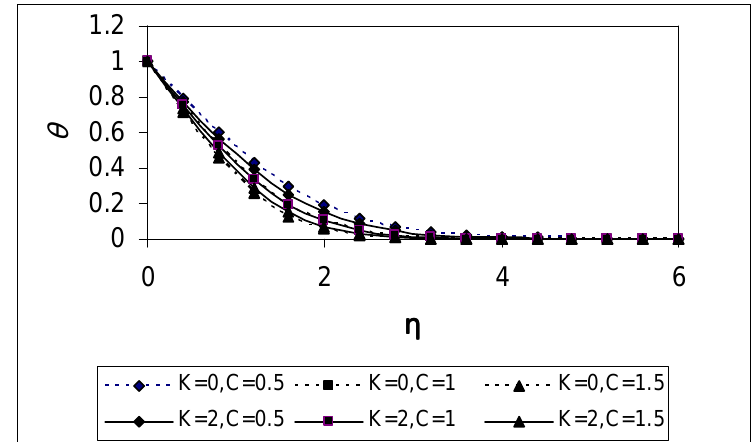
Fig. 2. Effect of the parameters C and K on the profile of q ( Pr =0.7, B